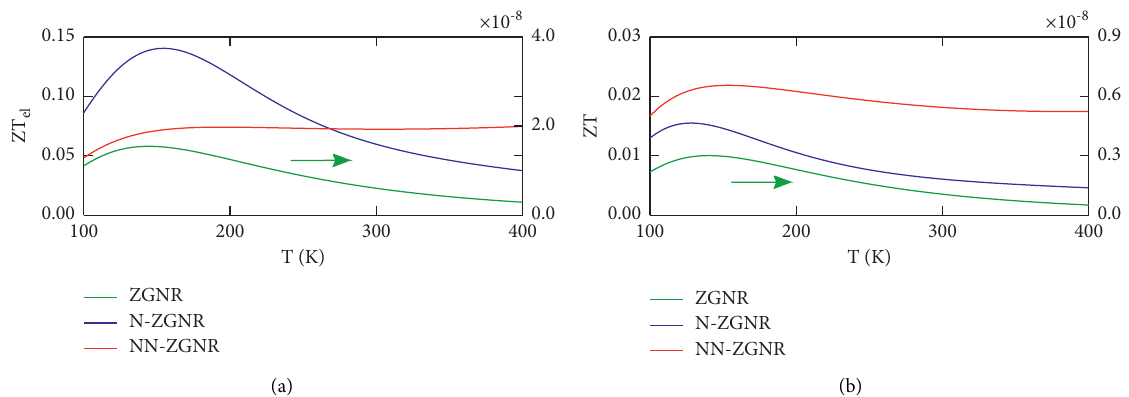
Figure 5: Temperature dependency of electron contribution to the figure of merit (a) and total figure of merit (b) calculated for the ZGNR (green), N-ZGNR (blue), and NN-ZGNR (red) systems. The colored arrows indicate that the corresponding curves are depicted against the y2-axis (right).